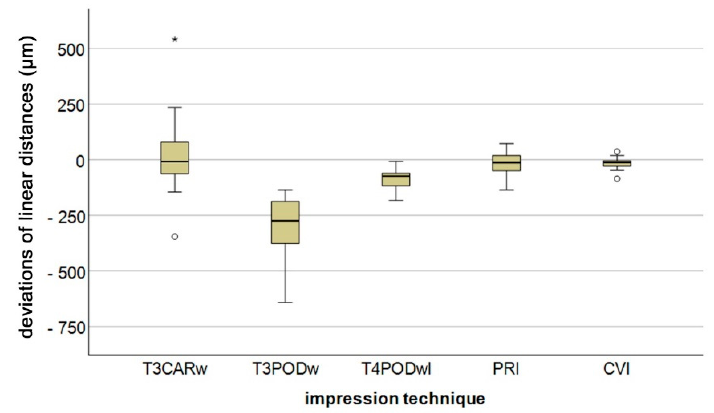
Figure 4. Boxplot diagram of long distance pooled data (except linear distance D1_2 and D3_4) of the deviations of linear distances for the different impression techniques (Trios 3 Cart wired (T3CARw), Trios 3 Pod wired (T3PODw), Trios 4 Pod wireless (T4PODwl), Primescan (PRI), conventional impression (CVI); outliers ( ○ ), extreme values (*)). (cid:35) Table 1. Deviations (Mean ± standard deviation (SD) ( µ m)) of the linear distances (D1_2, D1_3, D1_4,